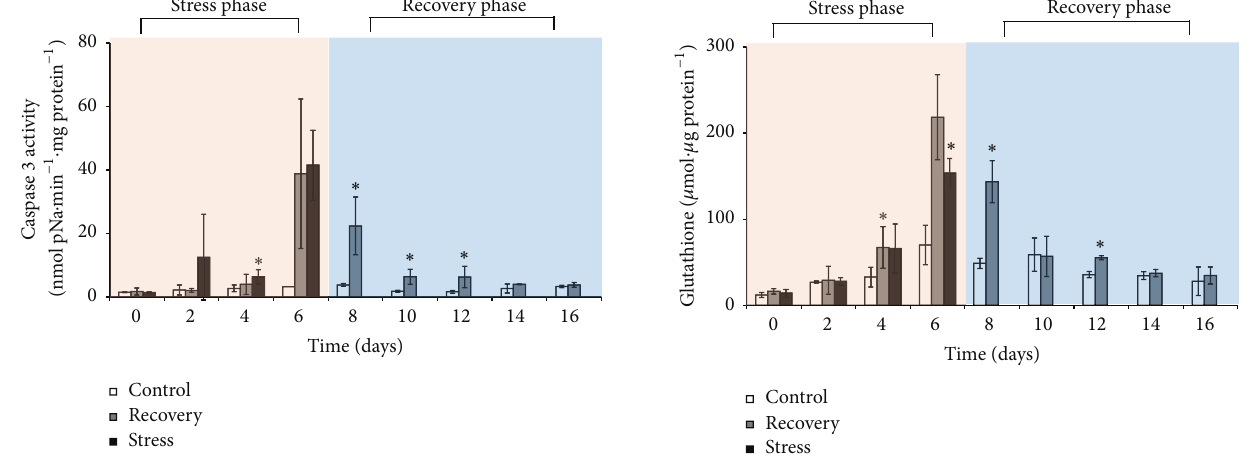
Figure 8: Total glutathione quantities in coral Pocillopora damicor- nis host fractions ( 𝑛 = 3 ) in control (26 ∘ C); recovery treatment (ramping from 26 ∘ C at day 0 to 32 ∘ C at day 6 then cooling to 26 ∘ at day 9); and stress treatment (ramping from 26 ∘ C at day 0 to 32 ∘ C at day 6) during 16 days. Asterisks ( ∗ ) stand for a significant difference ( 𝛼 = 0.05) .